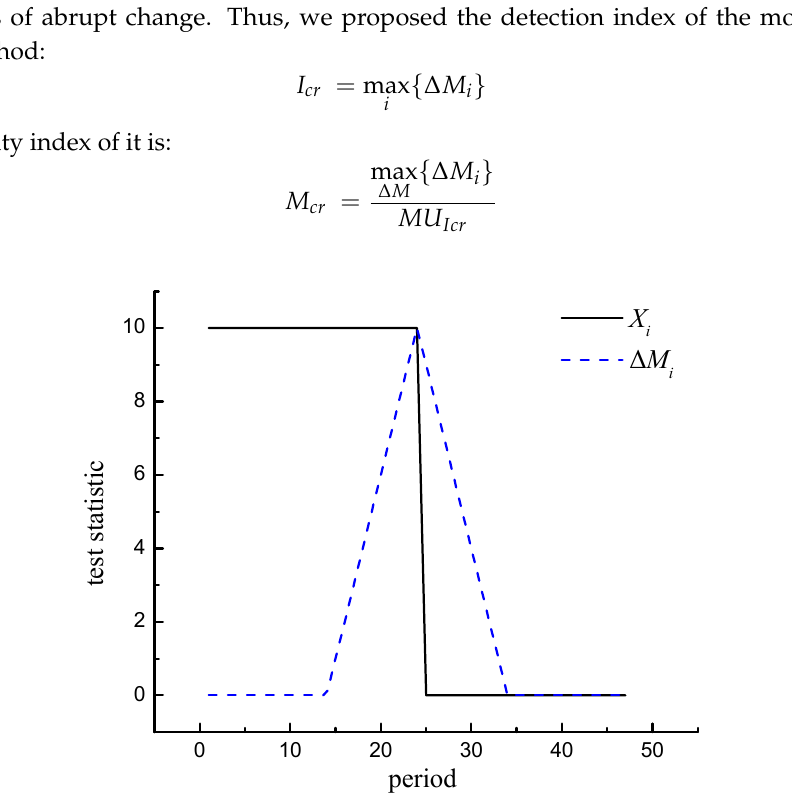
Figure 2. Single mutation point series without errors and moving average difference sequence.